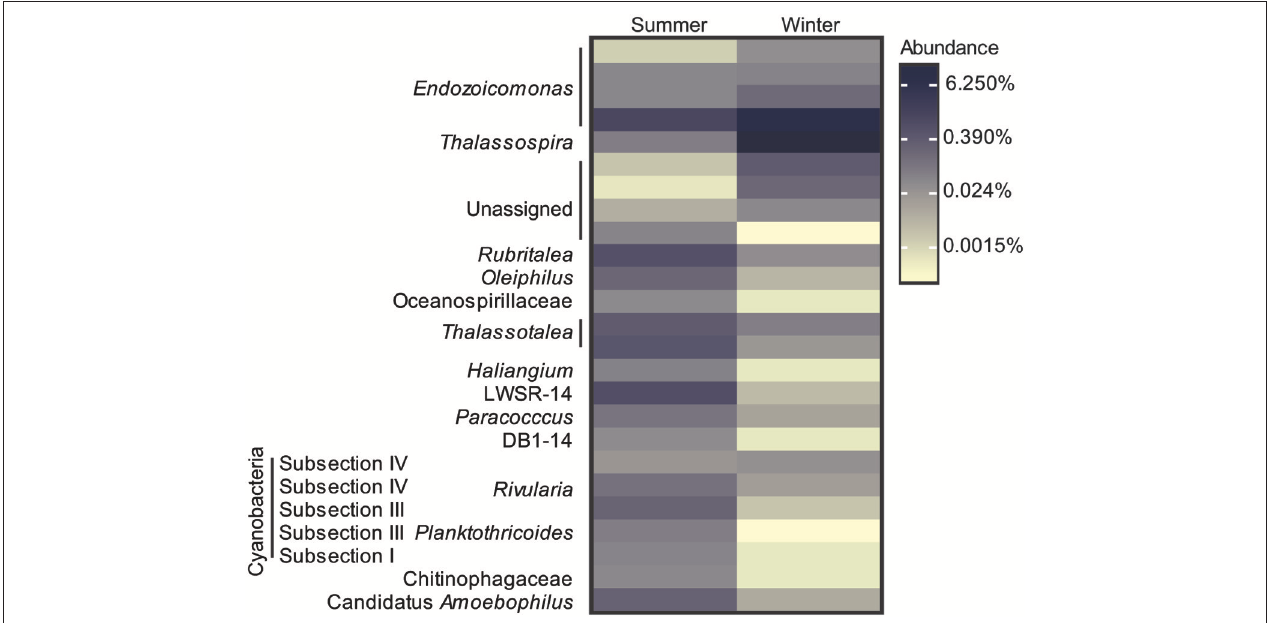
FIGURE 5 | Heatmap overview of bacterial OTUs associated with A. muricata that are differentially abundant between the summer and winter season under ambient UVR conditions.